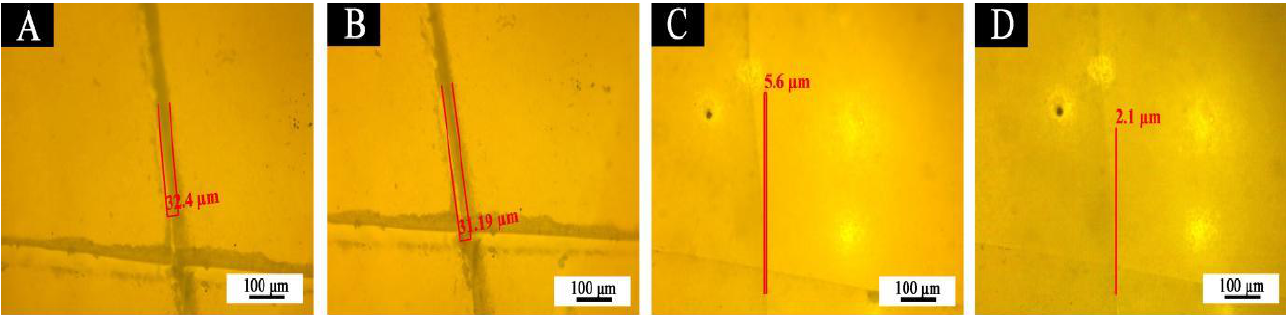
Figure 13. Infrared spectra of coating films with different contents of fluorane microcapsules.